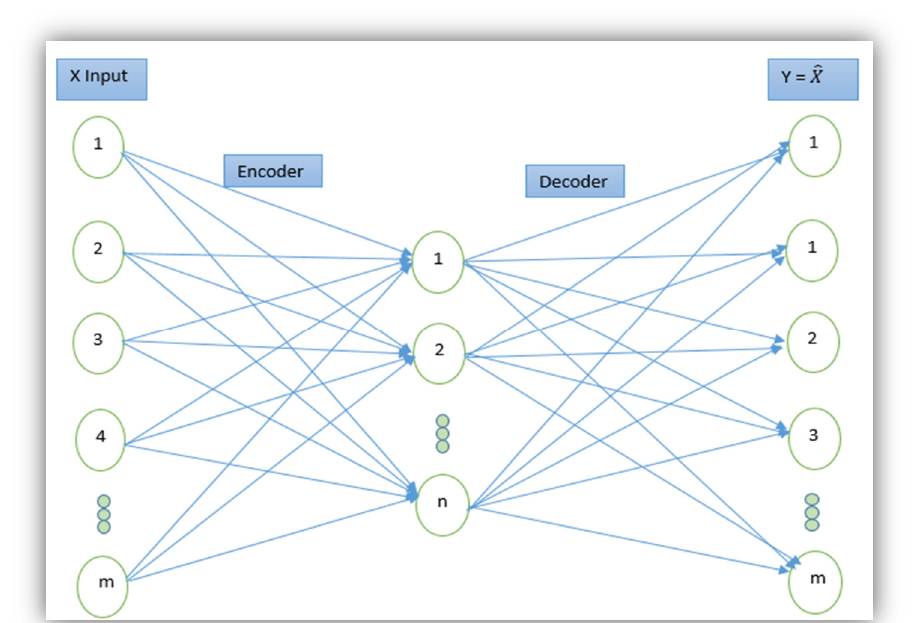
Fig. 1: Autoencoder- typical architecture with three hidden units, input x, and output y (reconstructed input)